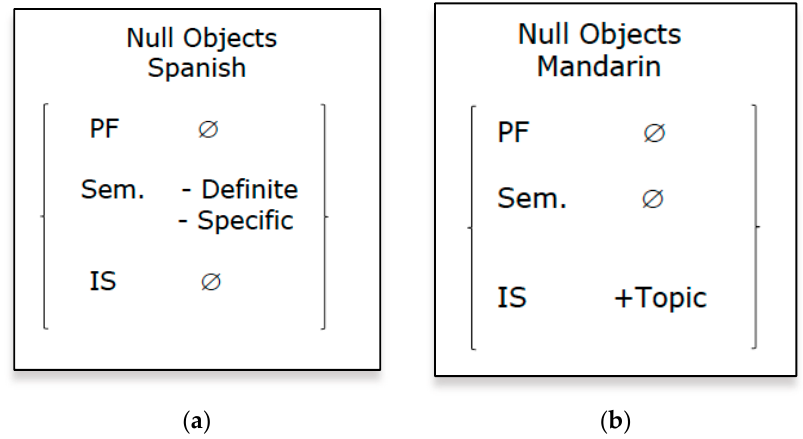
Figure 6. ( a ) Alignment for null objects in Mandarin; ( b ) alignment for null objects in Spanish.